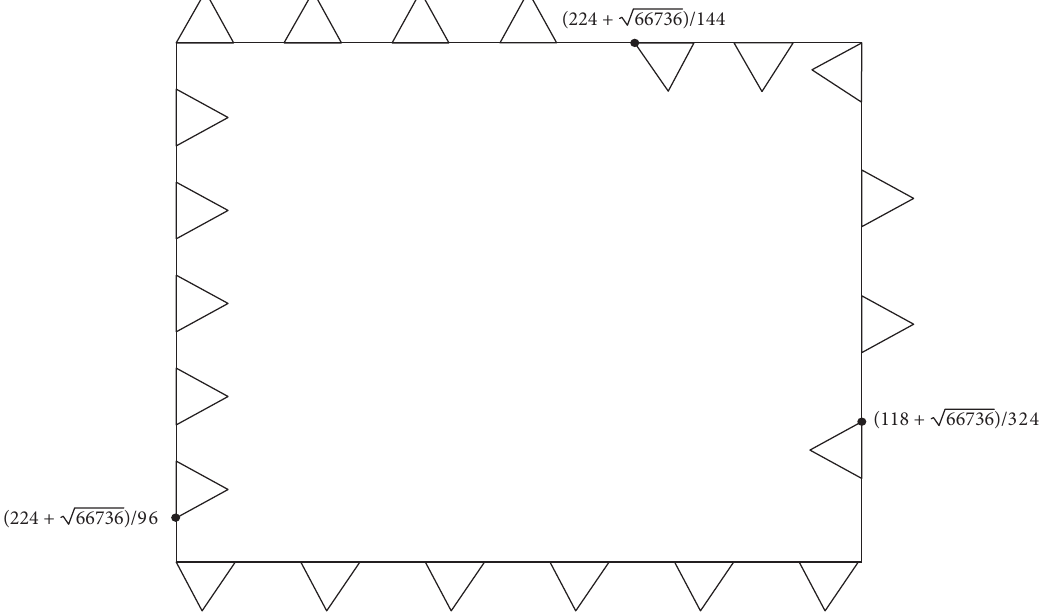
Figure 2: Shows the location of reduced numbers and describes that [ 2 , 3 , 4 , 5 , 6 , 1 ] ∼